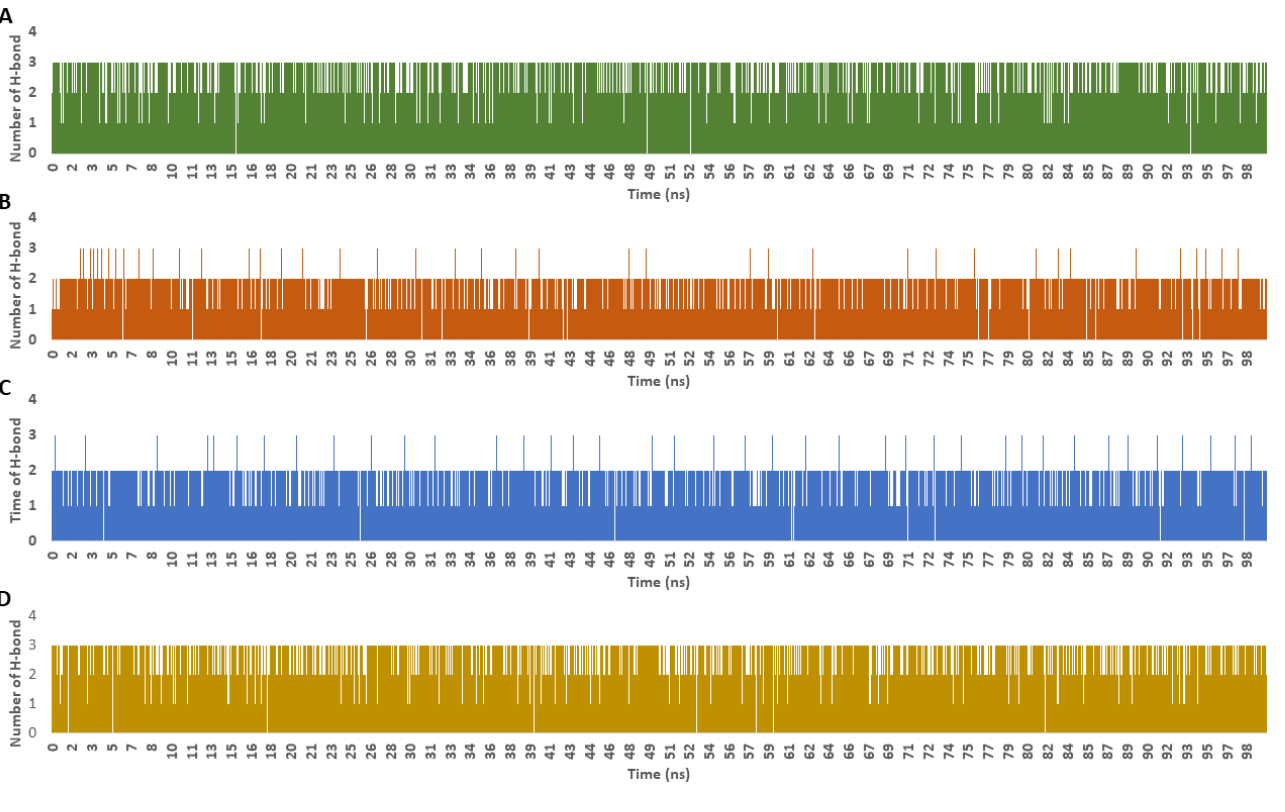
Figure 9. Number of H-bonds detected for calycopteretin-3-rutinoside, withanoside IX, and 4,16- dihydroxy-5 β ,6 β -epoxyphysagulin D along with the co-crystallized inhibitor inside the active site of NMT throughout 100 ns MDS runs (( A – D ), respectively). The cut-off distance for H-bonds was set to 3.0 Å. Table 3. Binding free energies (MM-PBSA) of top-scoring compounds along with the co-crystalized inhibitor in complex with